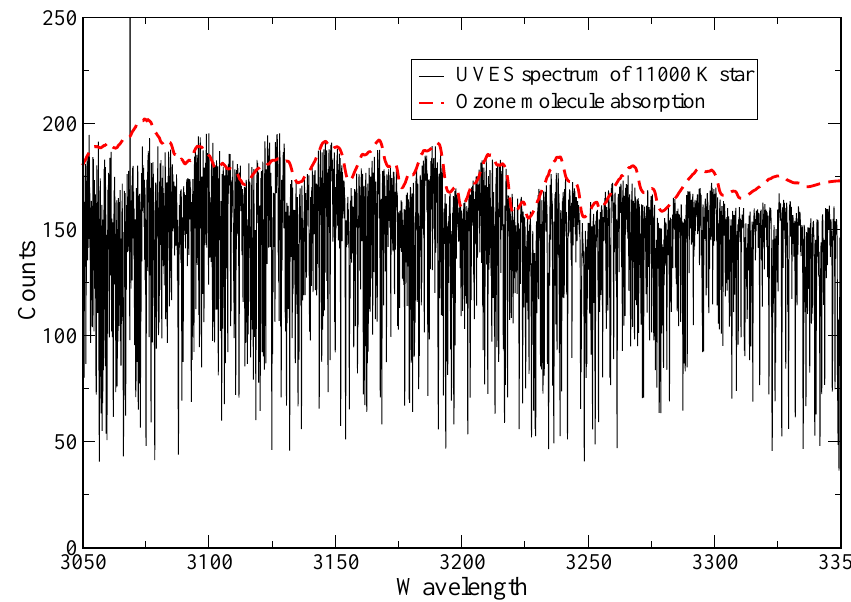
Fig. 3. The non-normalized spectrum of an 11 000 K star in the near ultraviolet range as observed with the UVES spectrograph. Depressions due to ozone molecule absorption (red dashed line) are clearly